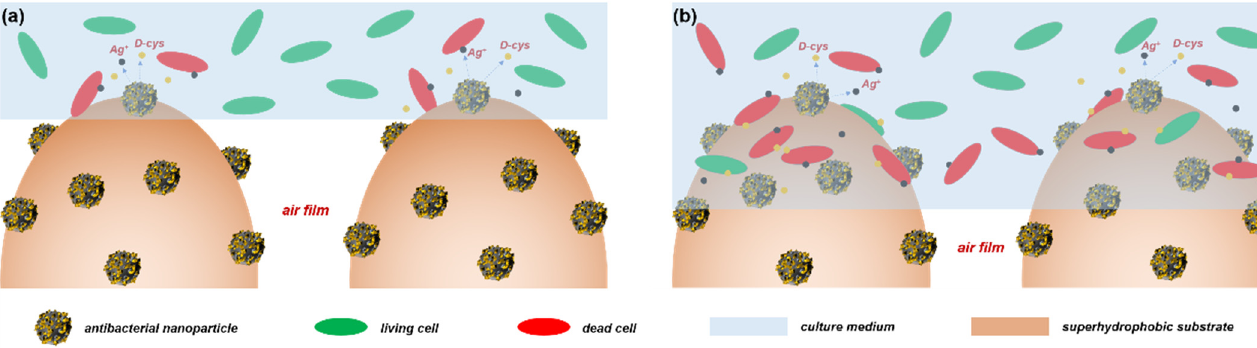
Figure 12. The schematic figure of the antibacterial behavior of the superhydrophobic nanocomposite coating on the ( a ) first day and ( b ) third day.